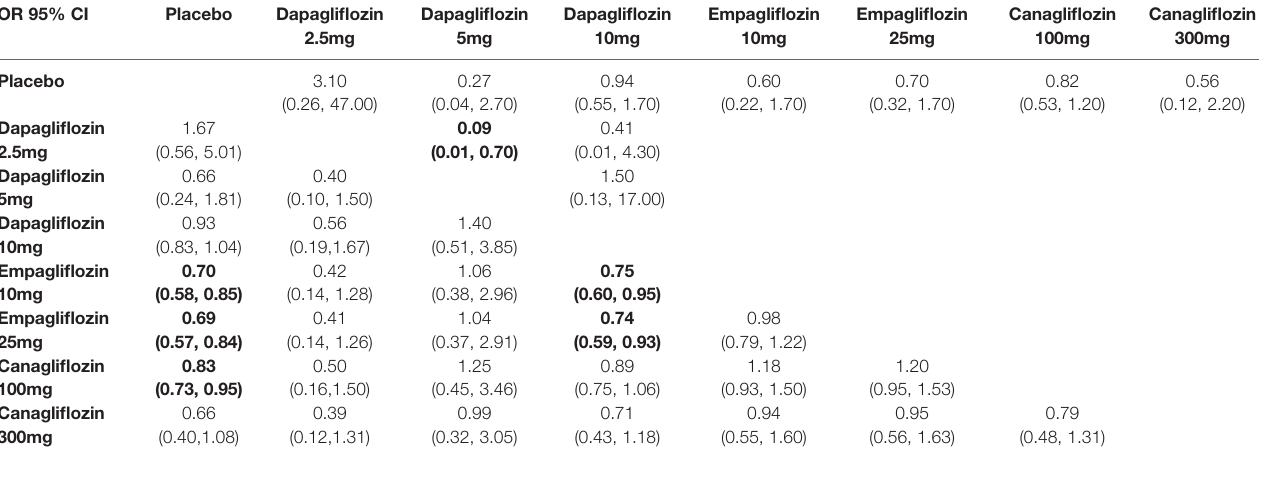
TABLE 3A | Summary of results from network meta-analysis and traditional pairwise meta-analysis on all-cause